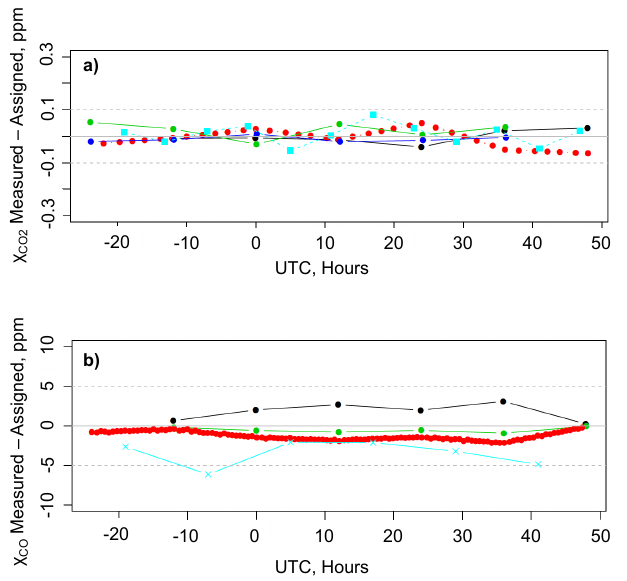
Fig. 5. Measured minus assigned values for (a) CO 2 stan- dards (black = CO2C1, red = CO2C2, green = CO2C3, dark blue = CO2C4, and cyan = CO2TGT) and (b) CO standards (red = COZER, black = COC1, green = COC2, cyan = COTGT) for a 3-day period from the LEF tall tower, where the central day is 6 August 2009.